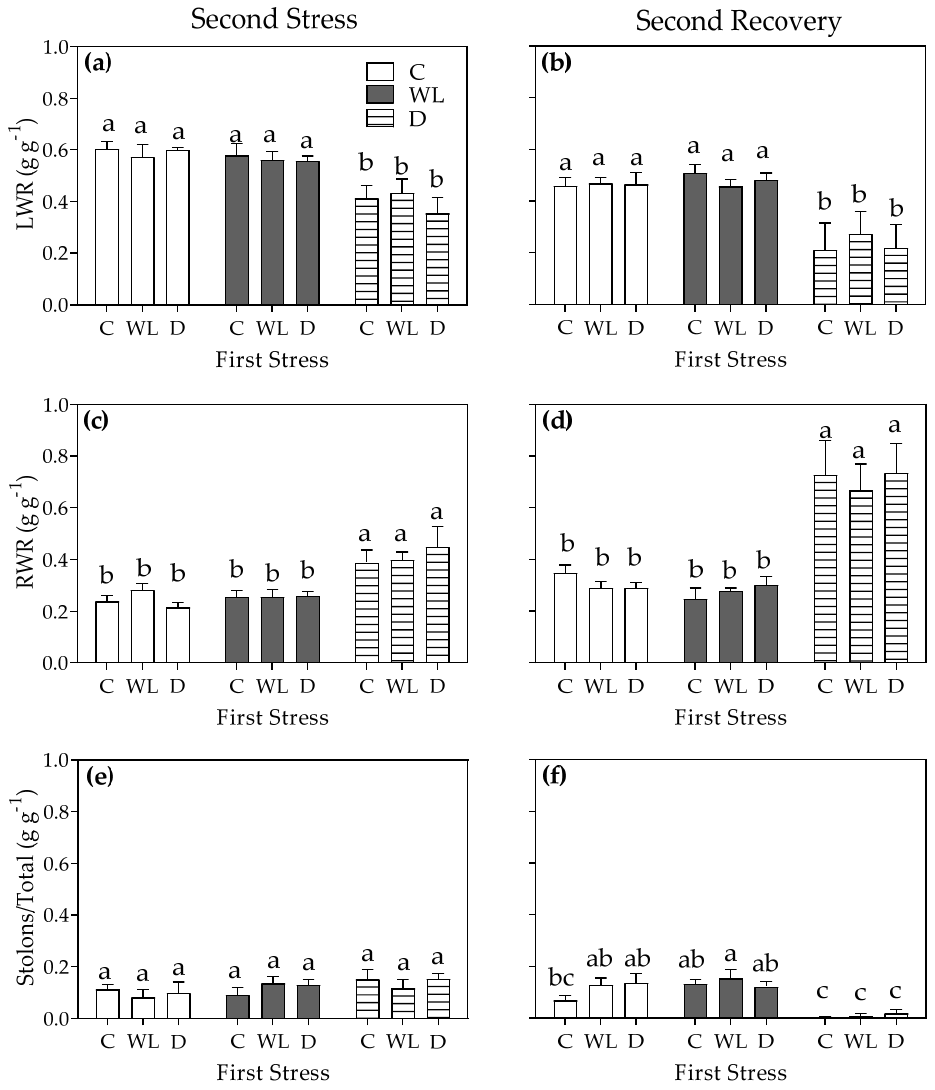
Figure 4. Leaf weight ratio (LWR; a , b ), root weight ratio (RWR; c , d ), and stolon/total ratio ( e , f ) of Chloris gayana plants subjected for 8 days to control conditions (C, white bars), waterlogging (WL, grey bars), or drought (D, striped bars) in the second stress round ( a , c , e ) and the subsequent 15-day recovery phase ( b , d , f ). Values are means ± e.e. (n = 8). Different letters indicate differences between treatments ( p < 0.05).